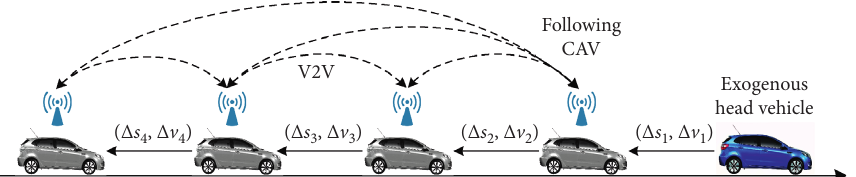
Figure 2: The platooning formations.